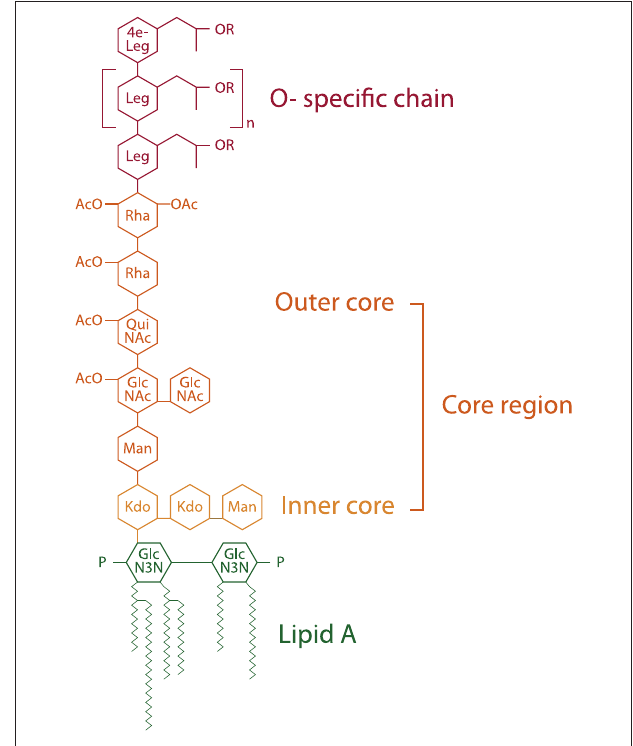
Figure 2 | Chemical structure of L. pneumophila LPS (modified from Kooistra et al., 2002b). Structure indicates its various regions: O-specific chain, core region consisting of the outer core and inner core and lipid A. Leg, derivatives of legionaminic acid; 4e-Leg, derivatives of 4-epilegionaminic acid; Rha, rhamnose; Man, mannose; QuiNAc, acetylquinovosamine; GlcNAc, acetylglucosamine; Kdo, 3-deoxy-d- manno -oct-2-ulosonic acid; P, phosphate; OAc,